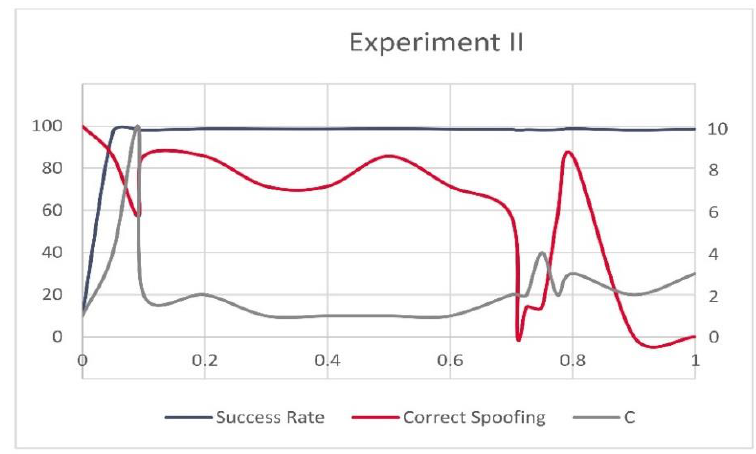
Figure 14. Success rate, correctly recognized spoofing records and C for Experiment II. Table 4. Confusion matrix for the independent meaconing validation dataset in Experiment I.